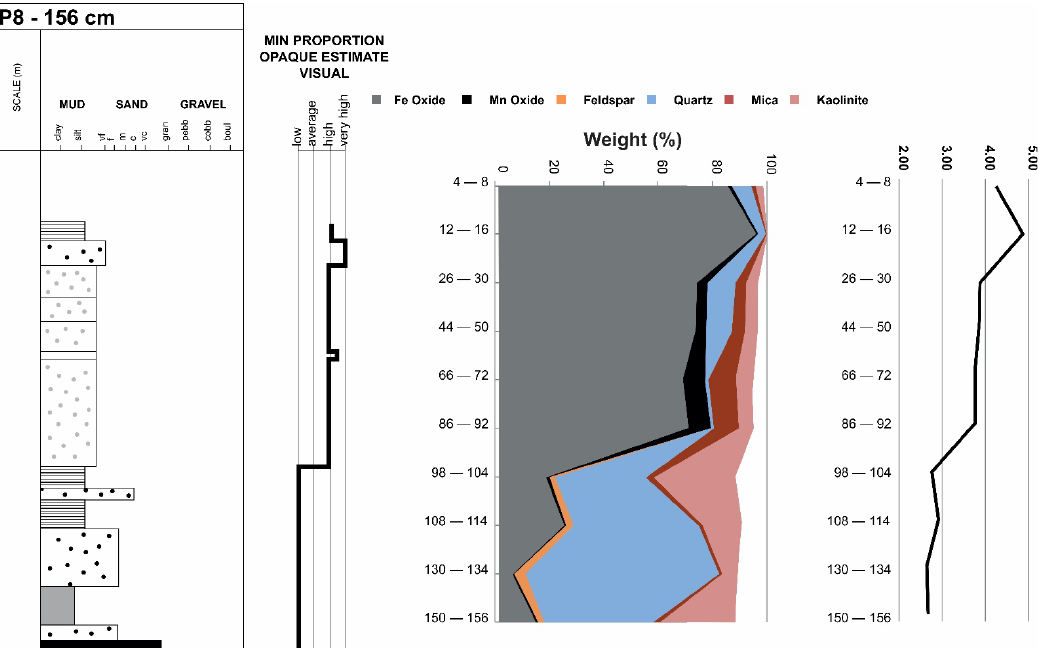
Figure 7. Multiproxy display of results obtained from P8 samples. From left to right one can observe the log with textural description, opaque relative proportions, modal mineralogy and density. Sampled intervals are indicated by the horizontal axis on the last two charts.